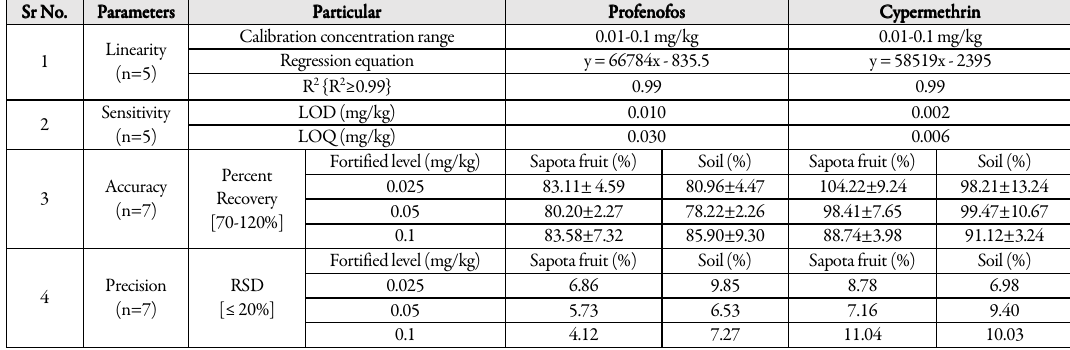
Table 1 Method validation parameters of profenofos and cypermethrin residues in sapota fruit and soil Sr